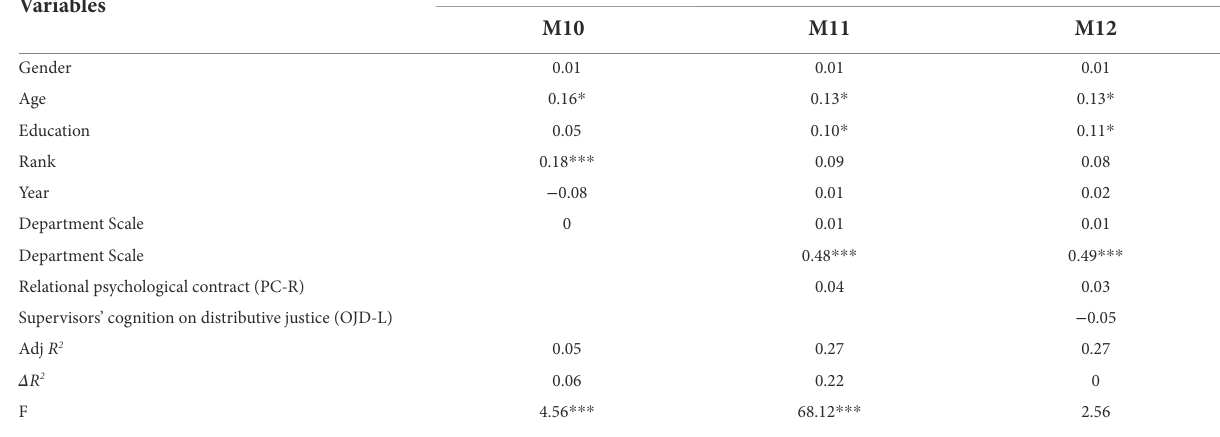
TABLE 8 Moderating effect of OJD-L to the relationship between PC-R and OI.